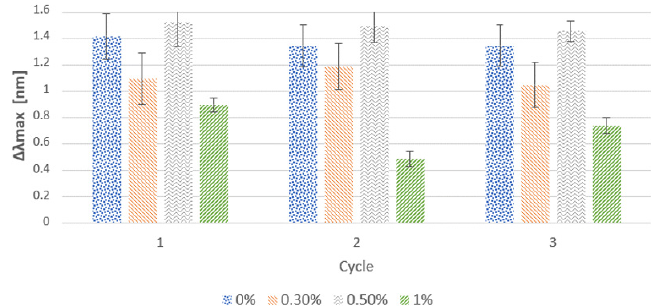
Figure 8. Δλ maximum for samples formulated with APG/CAPB 12 wt. %, cationic polymer 0.5 wt. %, and different levels of salt at room temperature and pH ~7.